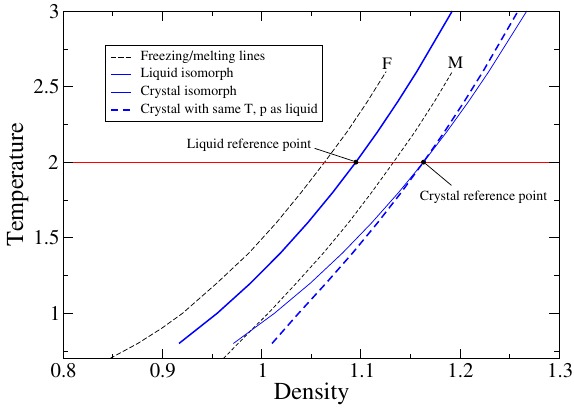
Figure 2: Illustration of how we calculate the driving force along a liquid isomorph (thick blue line) using data for the Lennard-Jones system. Notice that the liquid isomorph is to the right of the freezing line, that is, it is in the supercooled region. At a reference point on the liquid isomorph, specified by temperature T = 2.0, we know the crystal density which has the same pressure, and we know the driving force ∆ µ . We construct a crystal isomorph through that point. At a different temperature isomorph theory tells us the free energies on both isomorphs, but for a given temperature the pressures are the two isomorphs are no longer equal. A Taylor expansion gives the correction to the crystal’s free energy associated with fixing the pressure, and can also be used to find the corresponding crystal density (thick blue dashed